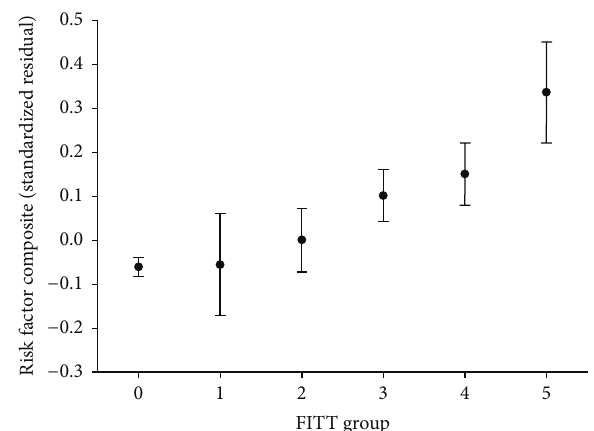
Figure 1: Risk factor composite by chronic pain severity groups. Adjusted for sex, age, education, alcohol use, exercise, and smoking. Chronic pain severity groups: pain dimensions: frequency, intensity, time, and total number of pain sites (FITT). 1 (low 4, high 0), 2